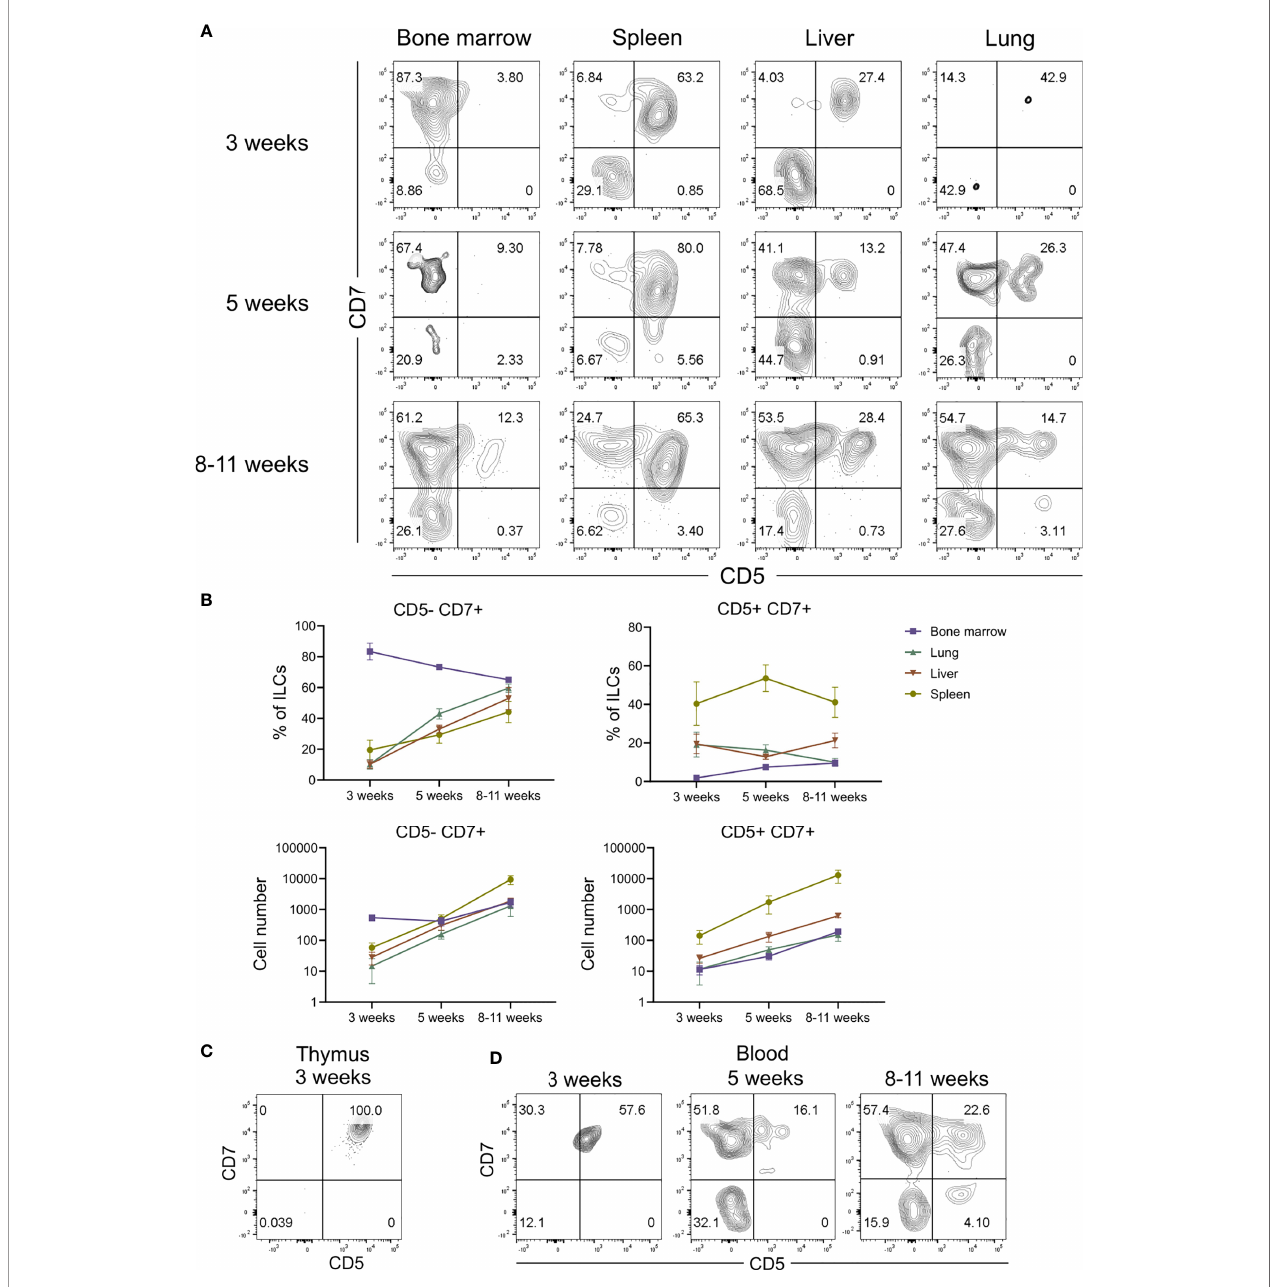
FIGURE 6 | CD5 + CD7 + ILCs have a distinct ontogeny compared to CD5 - CD7 + ILCs. (A) Flow cytometry analysis of CD5/CD7-expressing human ILCs in bone marrow, spleen, liver, and lung at 3 weeks, 5 weeks and 8-10 weeks after transplantation of MISTRG mice with human CD34 + HSPCs. ILCs were gated as human CD45 + Lin - CD3 - TCR ab - CD94 - CD127 + cells. (B) Frequency and numbers of CD5 - CD7 + and CD5 - CD7 + ILCs in bone marrow, spleen, liver, and lung of MISTRG mice at 3 weeks, 5 weeks and 8-10 weeks post-engraftment with HSPCs (n = 6-9). (C) Flow cytometry analysis of human CD5 + CD7 + ILCs in the thymus of MISTRG mice at 3 weeks after transplantation with human CD34 + HSPCs. (D) Flow cytometry analysis of human CD5 + CD7 + ILCs in the blood of MISTRG mice at 3 weeks, 5 weeks and 8-10 weeks after transplantation with human CD34 + HSPCs. Data represent mean ± SEM and are representative for at least two independent